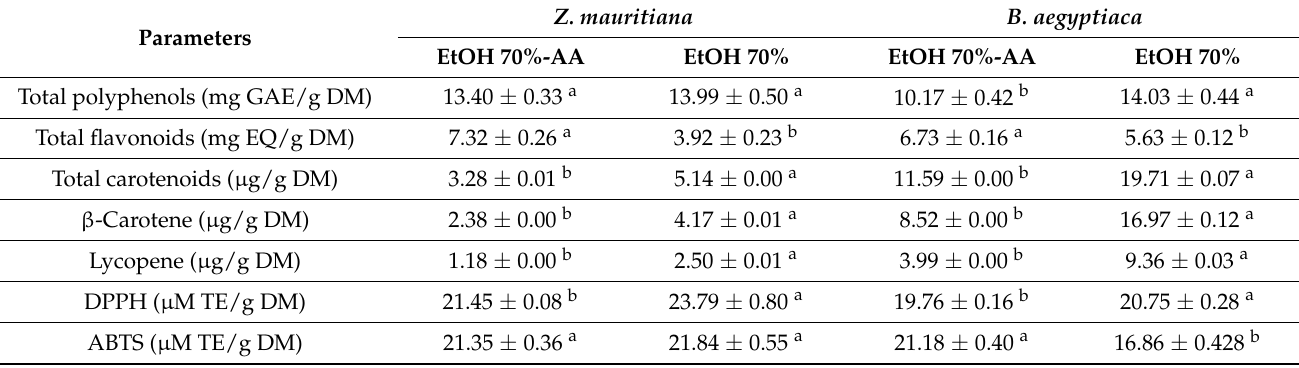
Table 1. Bioactive compound levels extracted by UAE from Ziziphus mauritiana and Balanites aegyptiaca fruits . Parameters